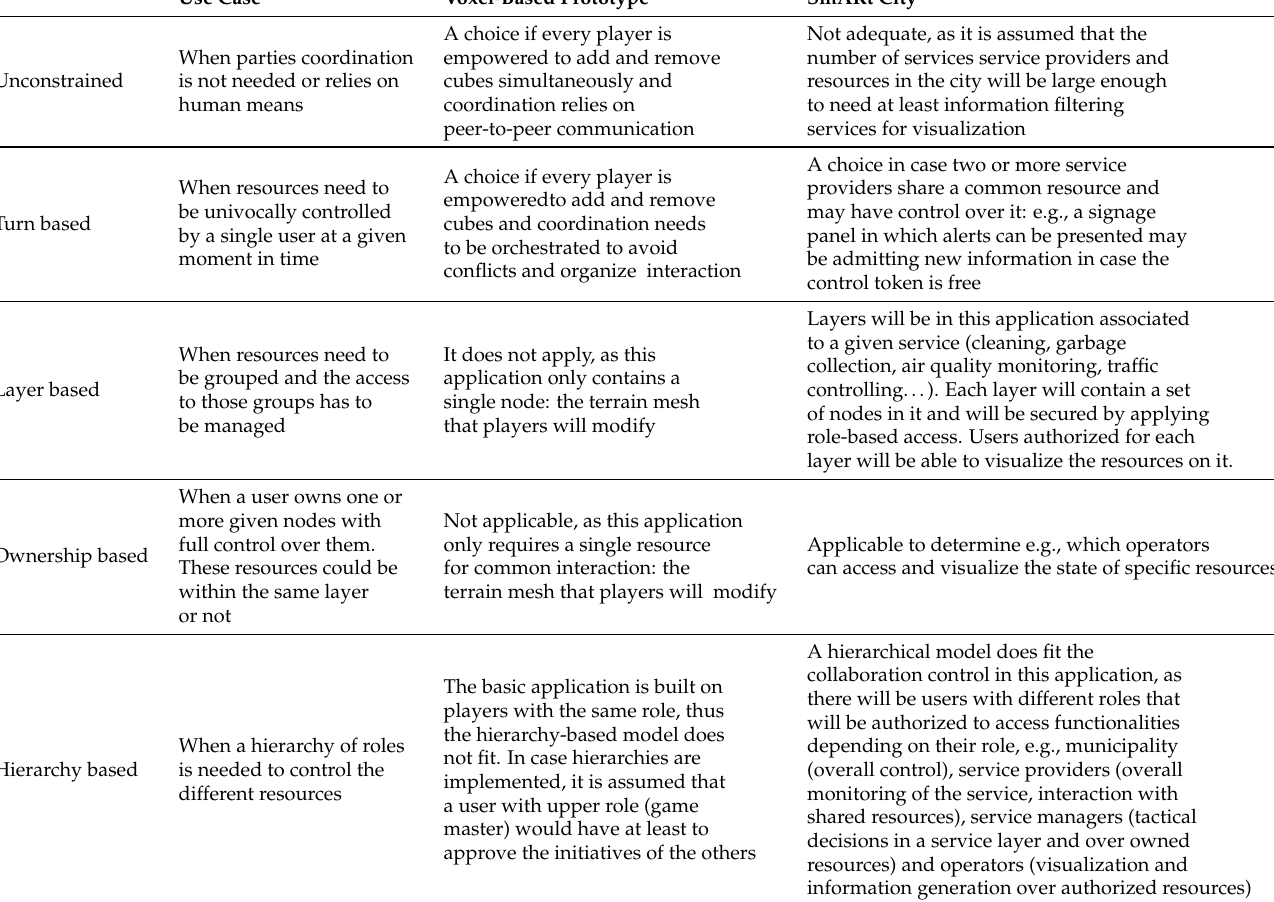
Table 1. Use cases of the collaboration models and it suitability for the voxel-based game and the SmARt city